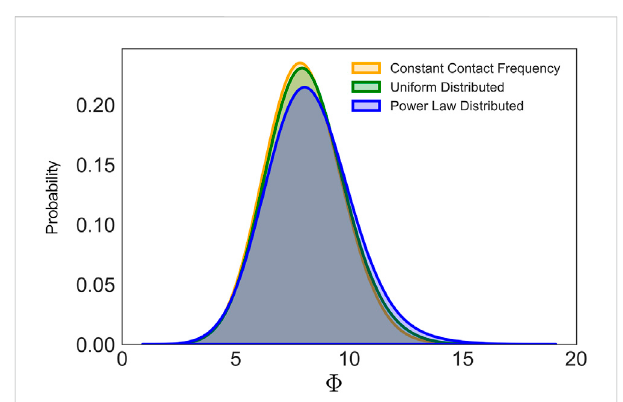
FIGURE 7 Probability density distribution of the possible hidden spreading span under the different choice of contact frequency. Holding the meanofthecontactfrequencyas 0.05, wecompared thein fl uenceof contact frequency on the possible hidden spreading